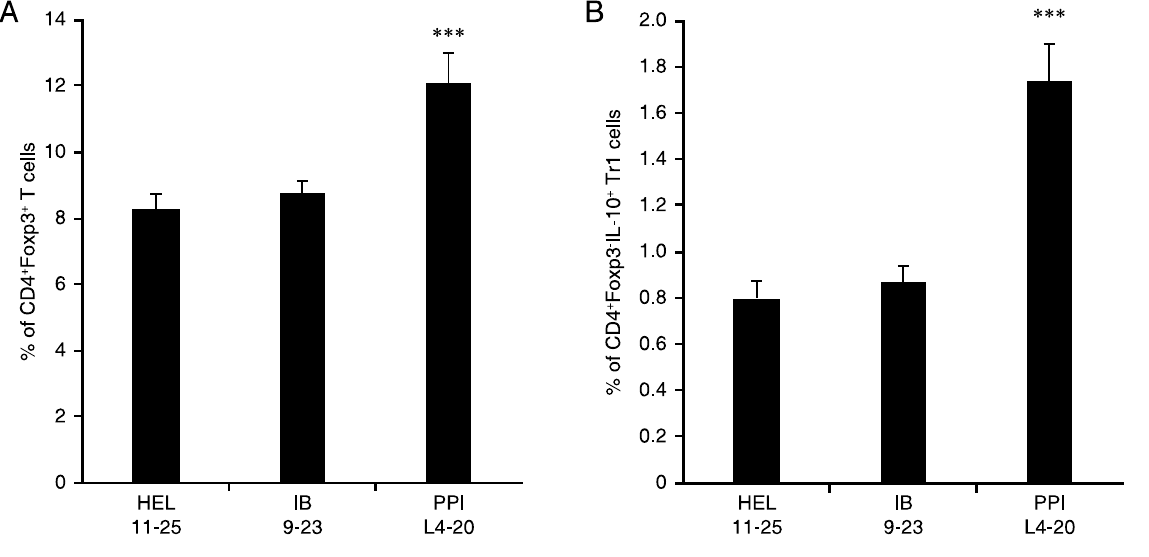
Figure 5. Immunization with PPI L4-20 increases the frequency of splenic Tregs and Tr1-like cells in NOD mice. Female NOD mice at 15–16 weeks of age were immunized IP with each antigen peptide in alum twice. Ten days later, their splenic mononuclear cells were isolated. The cells were stained with FITC-anti-CD4, fixed and permeabilized, followed by intracellular staining with PE-anti-Foxp3 or together with APC-anti-IL-10 for determining the frequency of ( A ) Tregs and ( B ) CD4 + Foxp3 - IL-10 + Tr1-like cells in total CD4 + T cells by flow cytometry. Data are expressed as the mean % ± SD of each group ( n = 5) from three separate experiments. *** p < 0.001 vs. the other groups as determined by Student’s t -test.